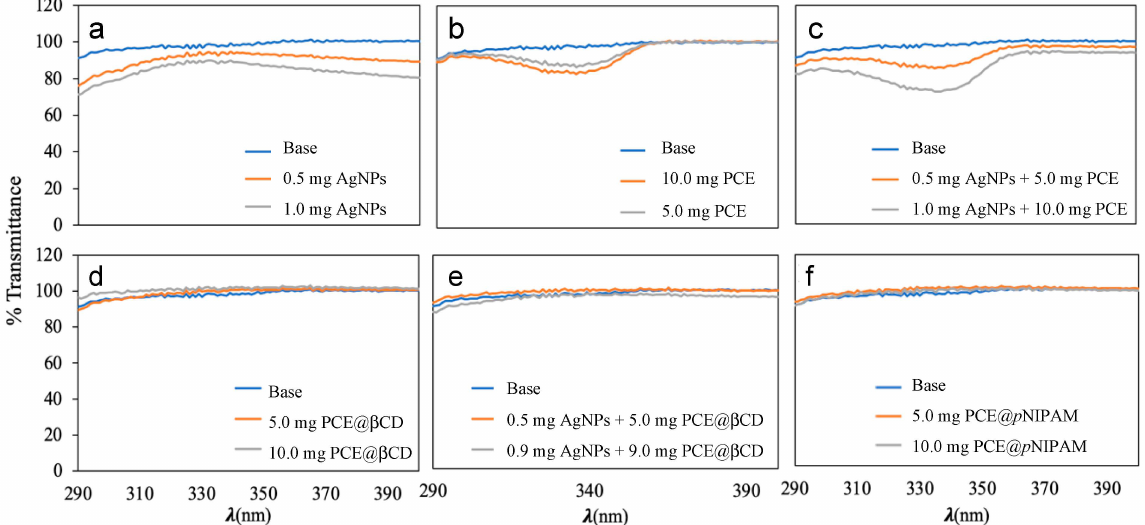
Figure 7. UV-Vis ( λ 290–400 nm) transmittance plots for ( a ) body cream with AgNPs, ( b ) body cream with PCE, ( c ) body cream with AgNPs and PCE, ( d ) body cream with PCE encapsulated in β CD, ( e ) body cream with AgNPs and PCE encapsulated in β CD and ( f ) body cream with PCE encapsulated in p NIPAM. Values are expressed as transmittance percentage (%) and quantities in mg in 1 g of body cream.